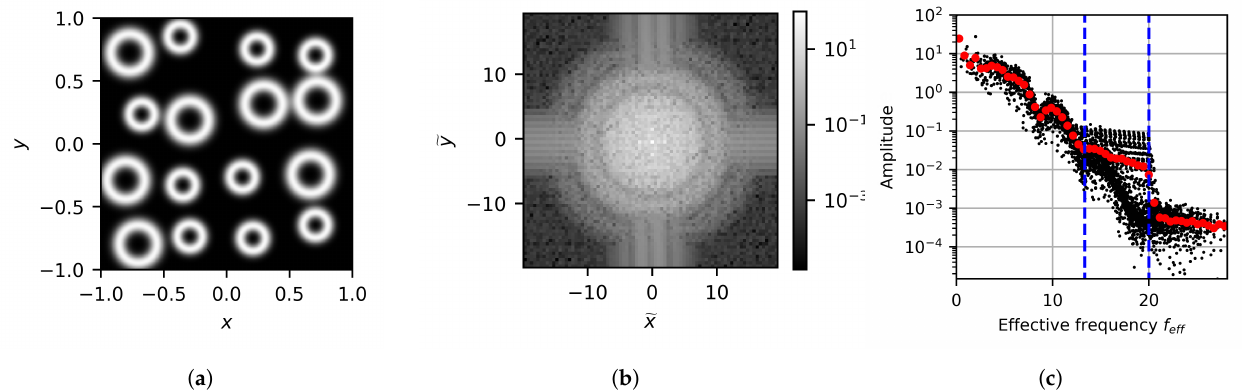
Figure 11. Image processing output for the multi-radius case showing ( a ) the generated image, ( b ) the FFT data, and ( c ) the FFT data projected onto the effective frequency